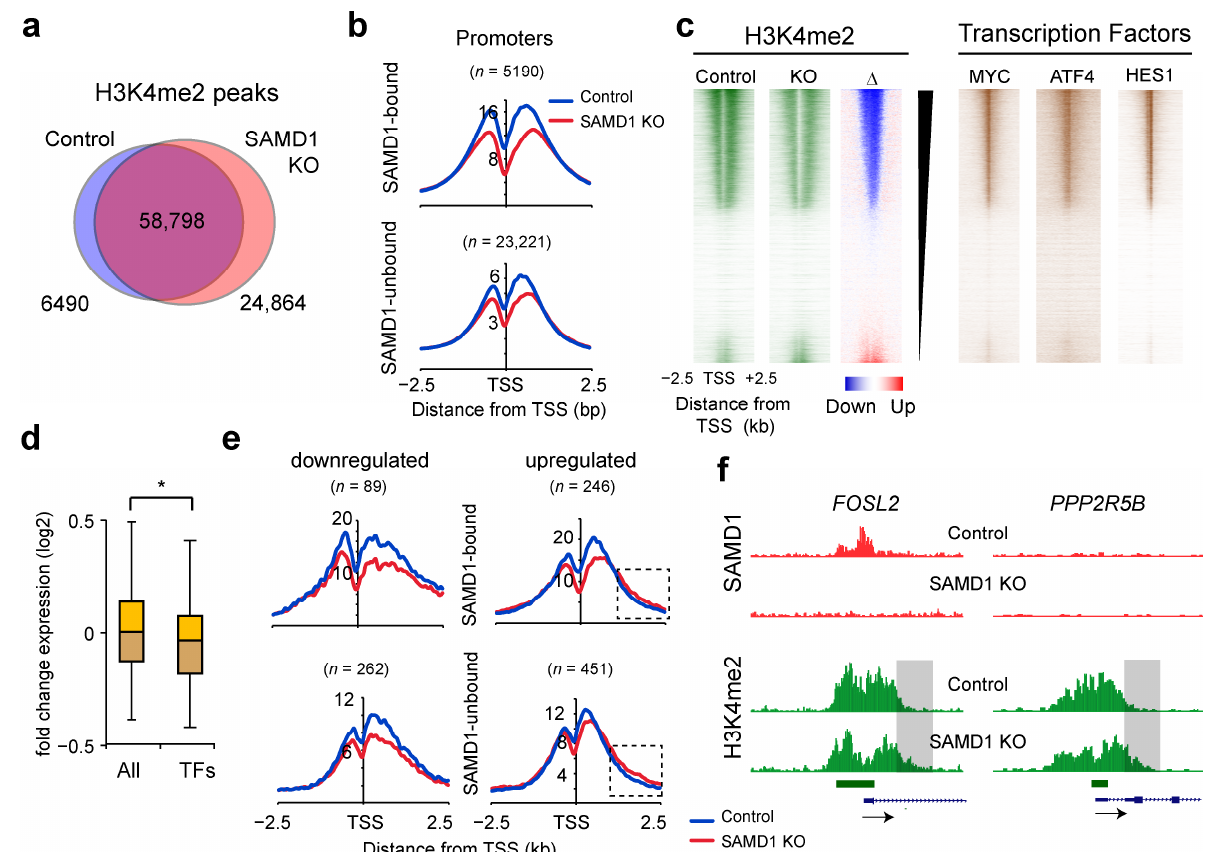
Figure 5. SAMD1 deletion leads to reduced H3K4me2 promoter levels independent of SAMD1 occupancy. ( a ) Venn diagram showing the overlap of significant H3K4me2 peaks in control and SAMD1 knockout cells. ( b ) H3K4me2 ChIP-Seq promoter profiles at SAMD1-bound and SAMD1-unbound promoters. ( c ) Heatmap showing the overlap of reduced H3K4me2 with three example transcription factors. ( d ) Gene expression changes of transcription factors [26] ( n = 1386) in SAMD1 KO cells compared to all genes. Box plots represent upper and lower quartiles of the data with 5 and 95% whiskers. Significance was evaluated using ANOVA. * p < 0.01. ( e ) H3K4me2 ChIP-Seq promoter profiles of up- and downregulated genes. ( f ) Example ChIP-Seq data of upregulated genes that show increased H3K4me2 downstream of the